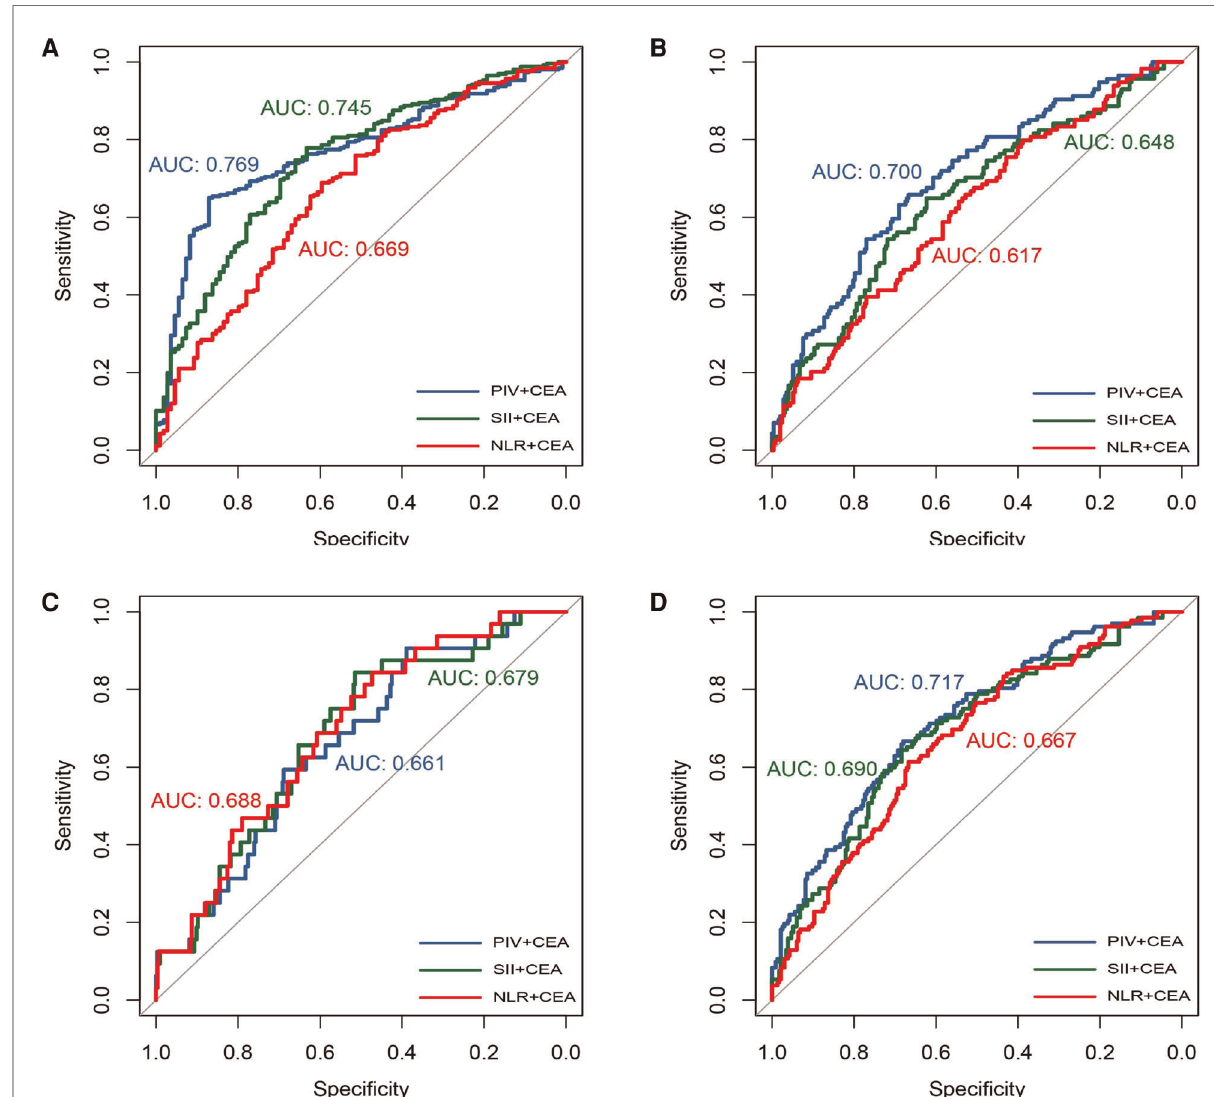
FIGURE 2 IIBS combined with CEA. Receiver operating curve analysis of T-stage ( A ); Receiver operating curve analysis of N-stage ( B ); Receiver operating curve analysis of M-stage ( C ); Receiver operating curve analysis of TNM-stage ( D